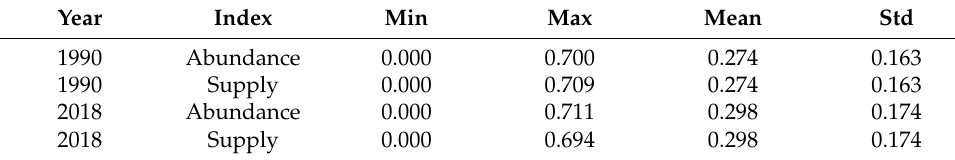
Table 2. Statistics of InVEST crop pollination model results in 1990 and